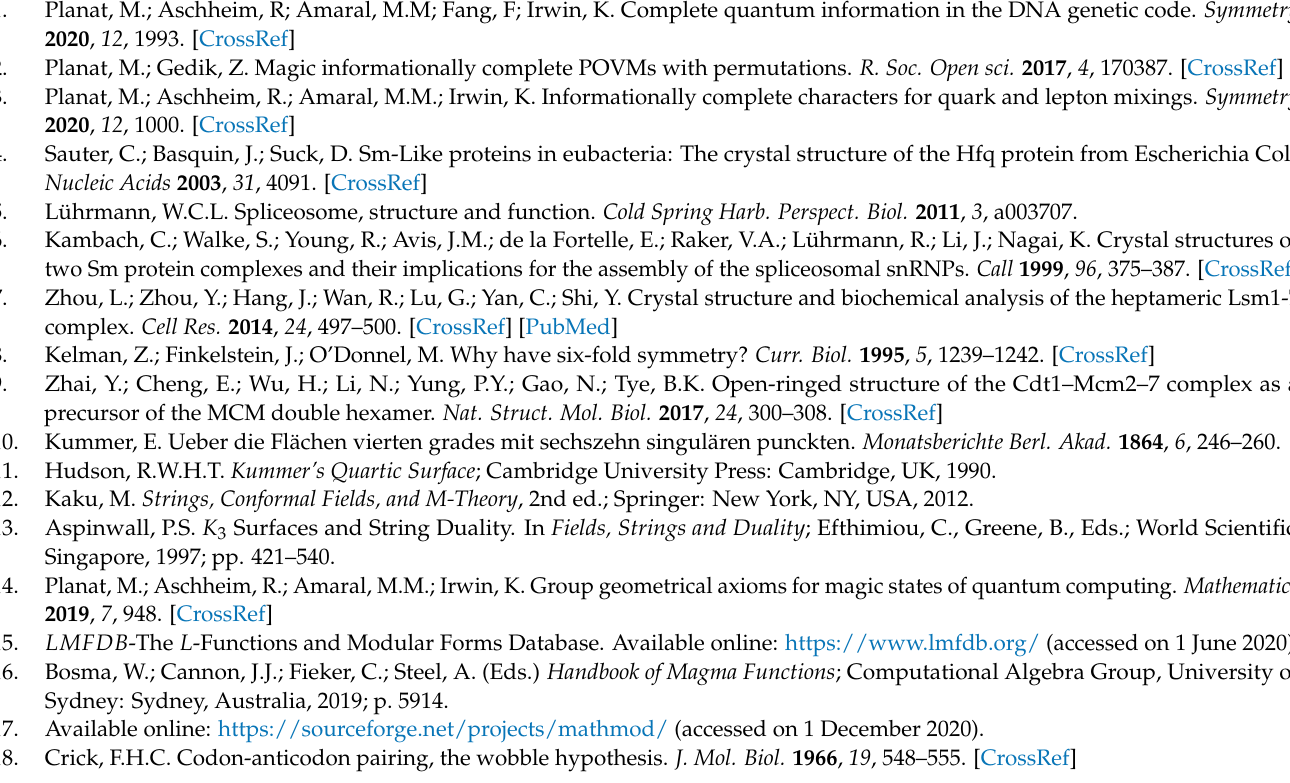
√ √ √ √ 5 + 1 ) /2, z 2 = 5 − 1, z 3 = 3 ( 1 + 5 ) /2, z 4 = 2,